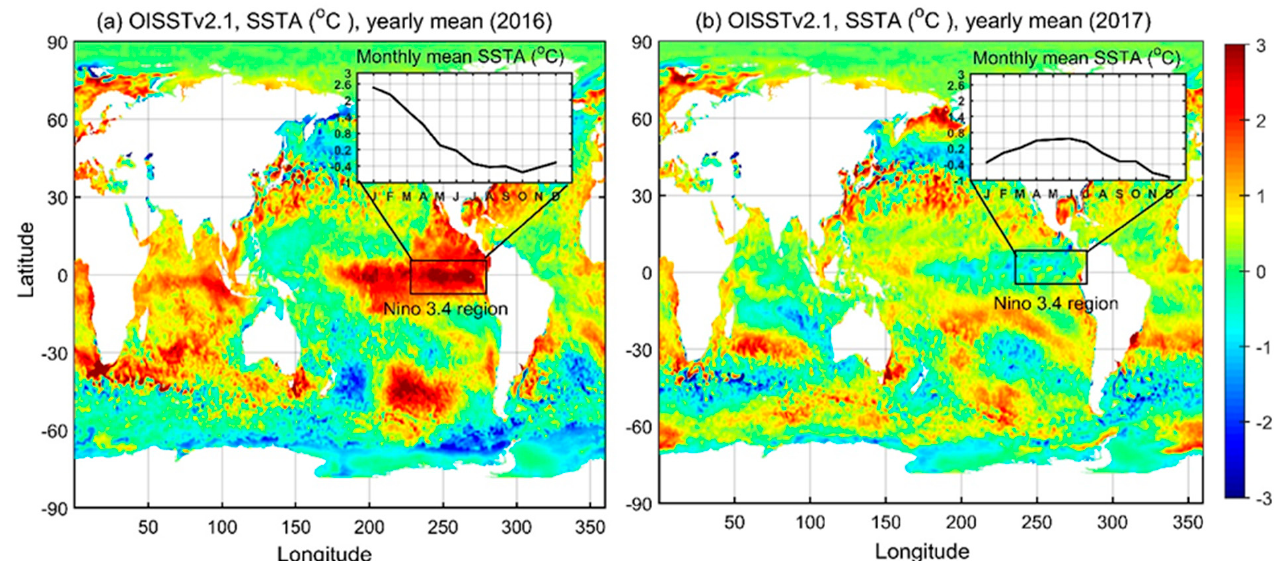
Figure 1. Yearly mean SST anomalies of world oceans in 2016 ( a ) and 2017 ( b ). The black boxes correspond to the Niño 3.4 area (5° S–5° N, 240–290° E) in the East Pacific Ocean. Monthly average SST anomalies in Niño 3.4 region are shown within the map.